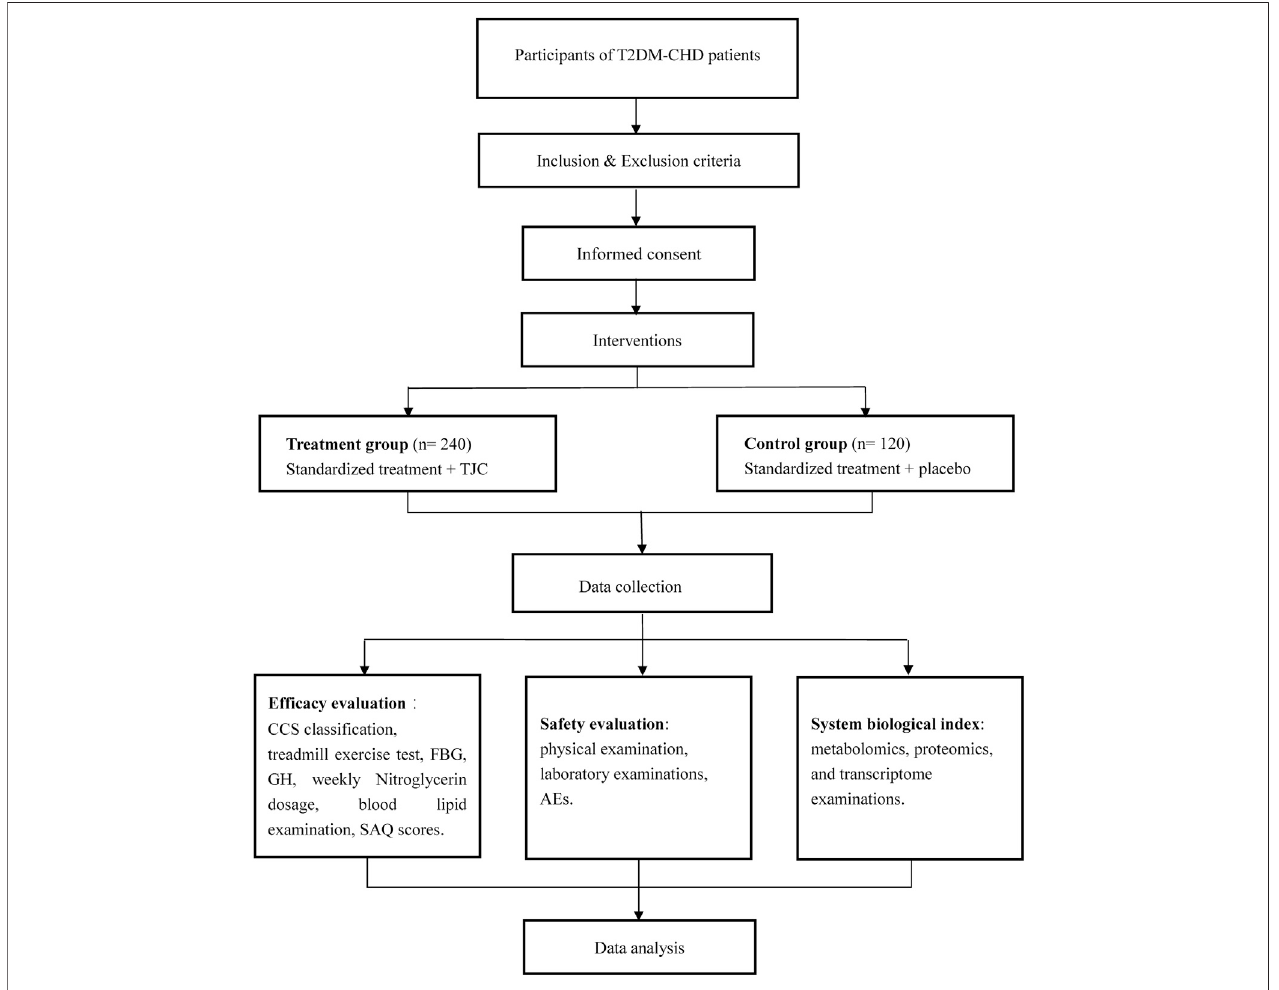
FIGURE 1 | Schedule of the trial. Abbreviations: T2DM- CHD, Type 2 diabetic coronary heart disease; TCJ, Tongmai Jiangtang capsules; CCS, Canadian Cardiovascular Society; FBG, fasting blood glucose; GH, glycosylated hemoglobin; SAQ, Seattle angina questionnaire; AE, adverse event.